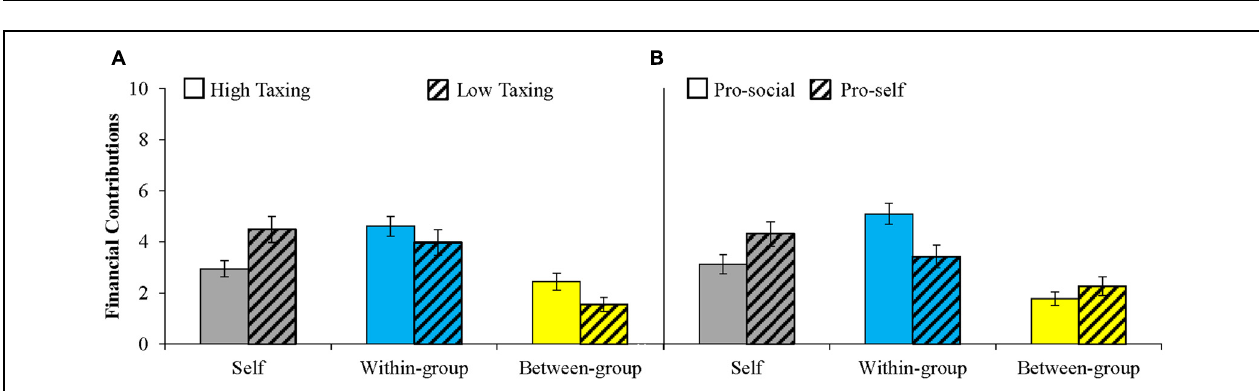
(A) Time (log-transformed seconds) taken to decide how much to keep positively relates to contribution to self. (B) Time (log-transformed seconds) taken to decide how much to keep negatively relates to in-group expectations.